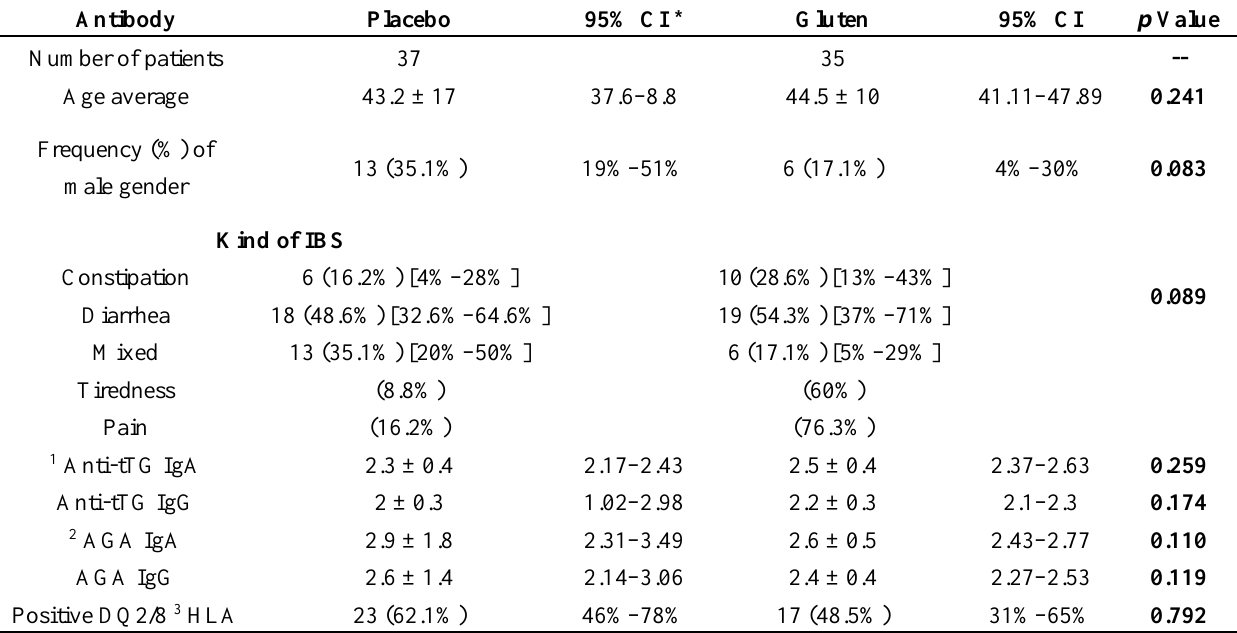
Table 1. Demographic and clinical characteristics of the gluten compared to placebo